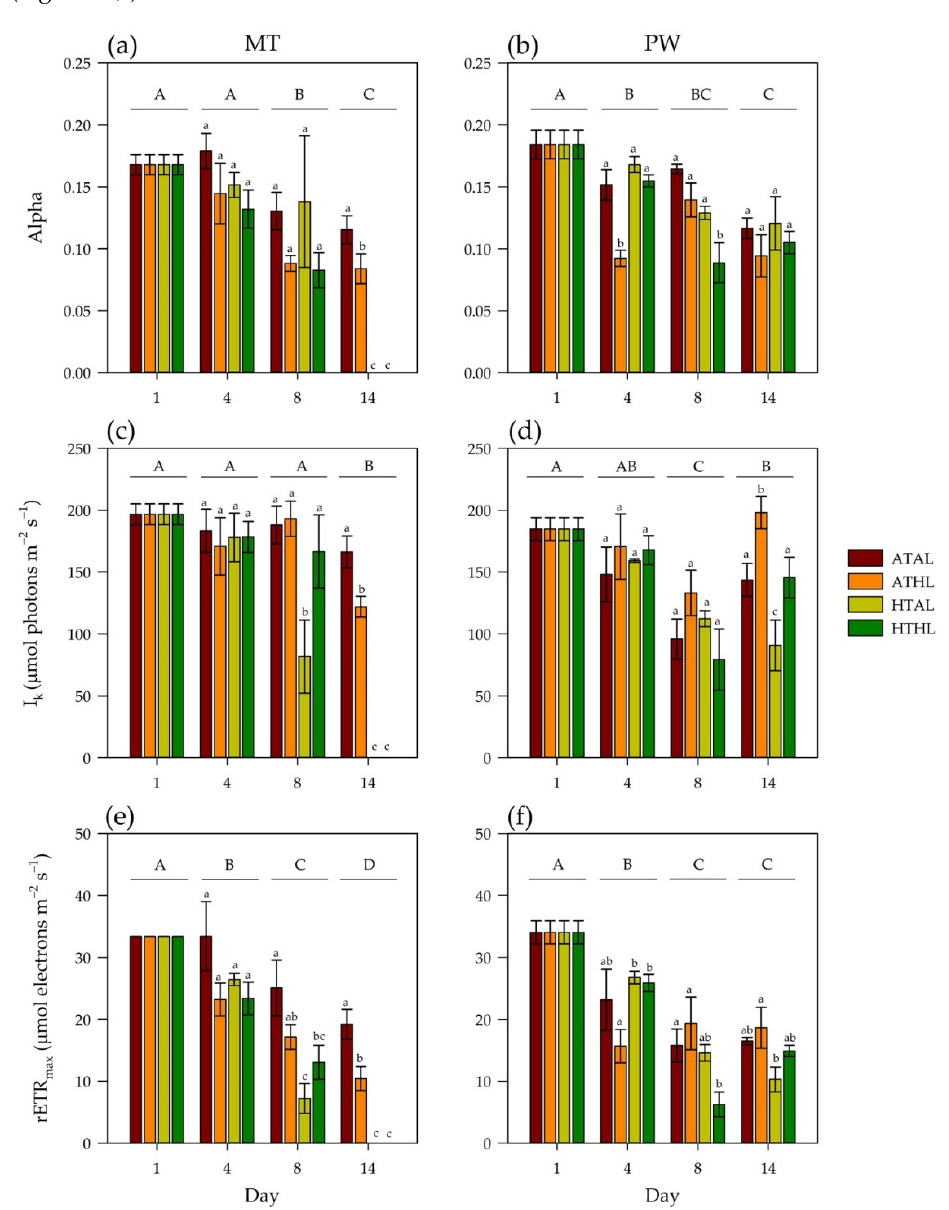
Figure 4. Alpha ( a , b ), minimum saturating irradiance ( c , d ), and maximum relative electron transport rate ( e , f ) of P. acuta from MT and PW at each sampling time. Data are presented as mean ± SE (n = 4). A, B, C, D and a, b, c, d indicate significant differences by time and by treatment, respec- tively.